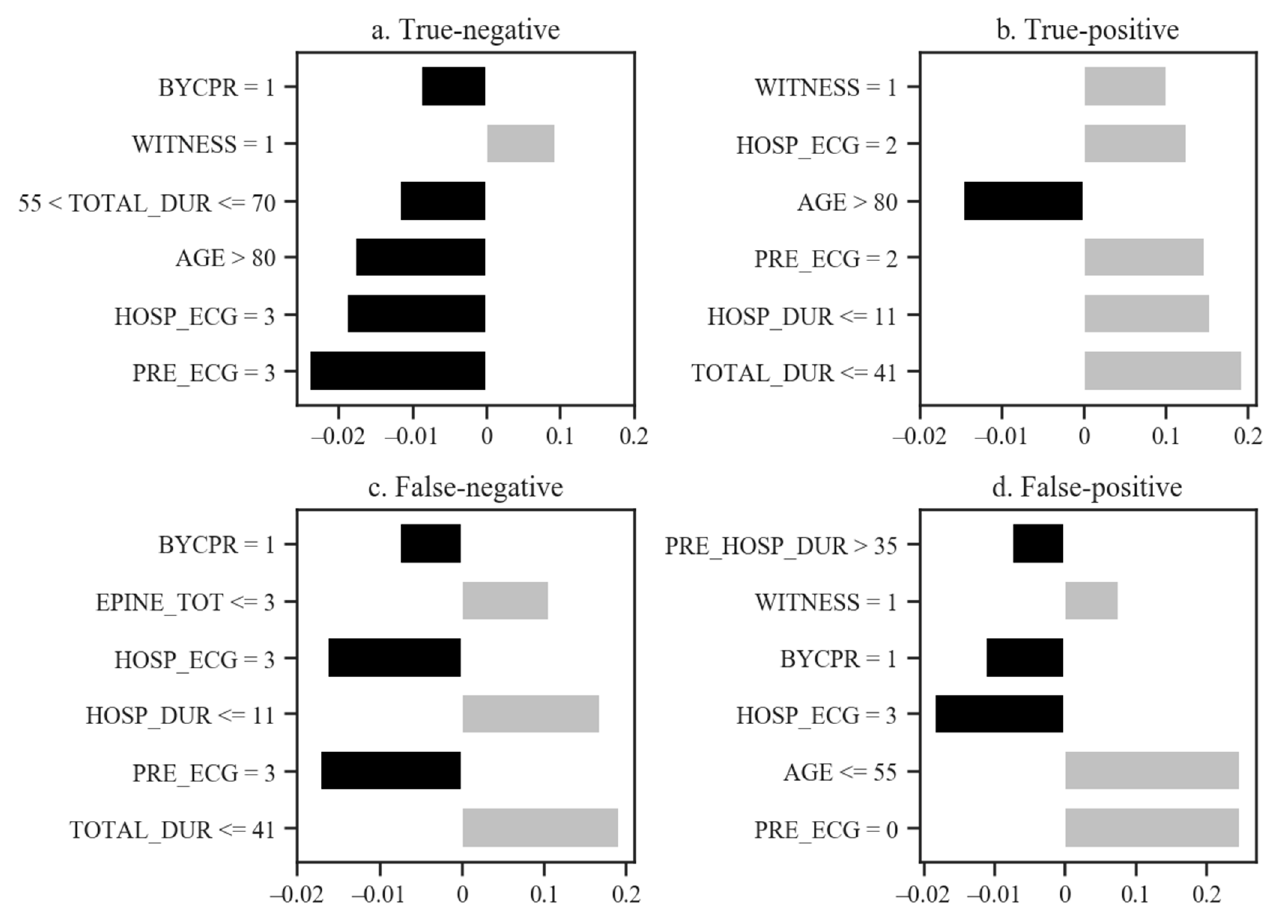
Figure 4. Why the model predicts the neurological outcomes of individual patients. Explainability of predicting neurological outcomes of ( a ) true-negative, ( b ) true-positive, ( c ) false-negative, and ( d ) false-positive cases. The x -axis is the probability of predicting prognosis for an individual patient. While other variables are fixed, a value of the x -axis for a feature speaks to how much to increase or decrease the predicted probability of the VC model. This VC model was trained using all variables in Table 1. The official names of the abbreviated variable names in this figure can be found in Appendix A, Table A1.